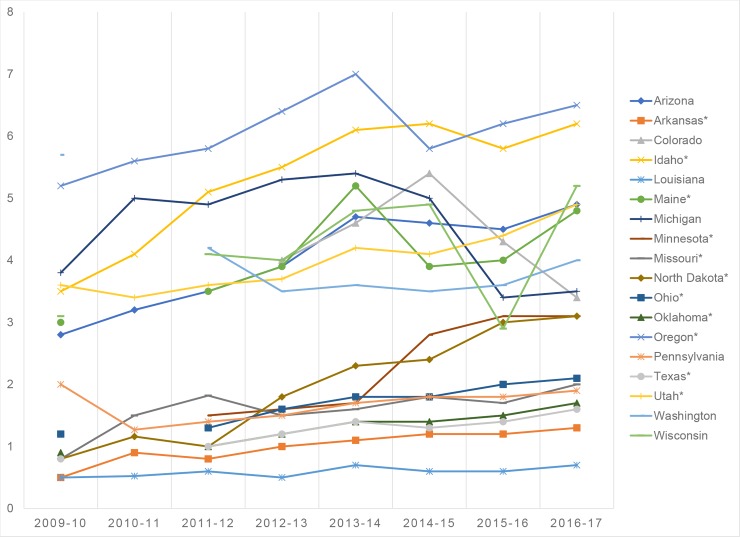
Increasing nationwide trend in kindergarten NME rates from 2009 to 2017.The asterisk (*) indicates states demonstrating an upward trend of kindergarteners with NMEs. NME, nonmedical exemption.